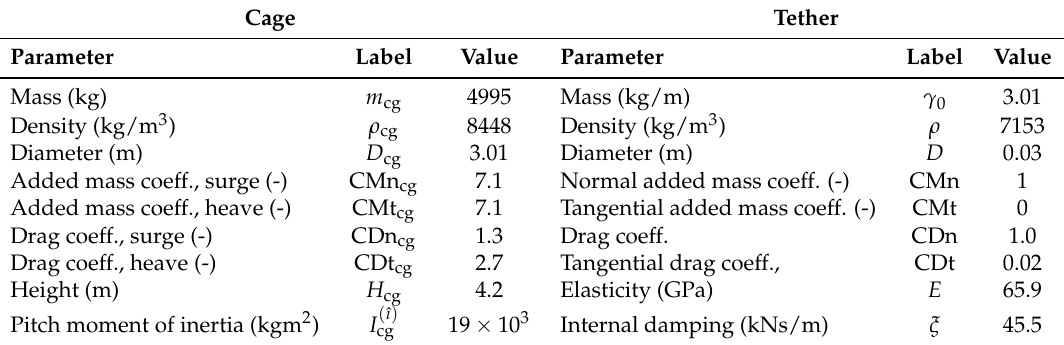
Table 3. Data used in the simulations of the ROPOS tether and cage. The parameters are adapted from [13,16,19]. Cage